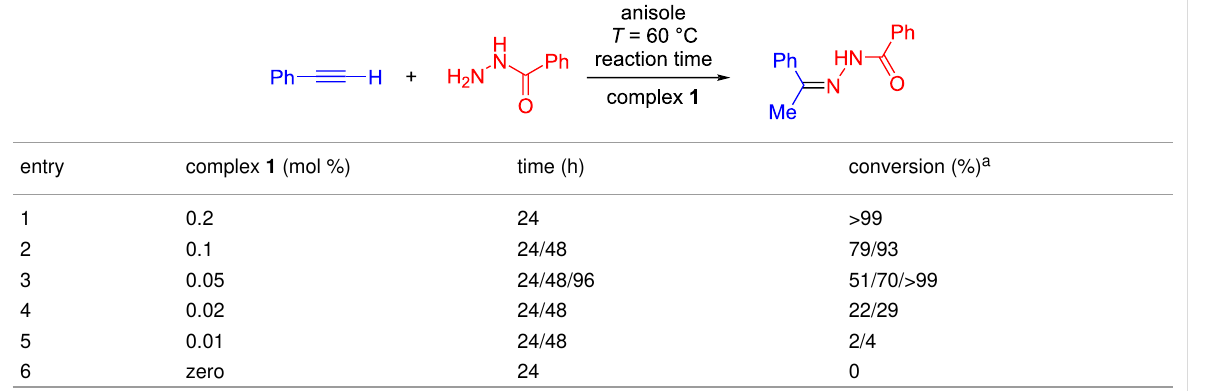
Table 2: Catalyst loading vs. reaction time in the